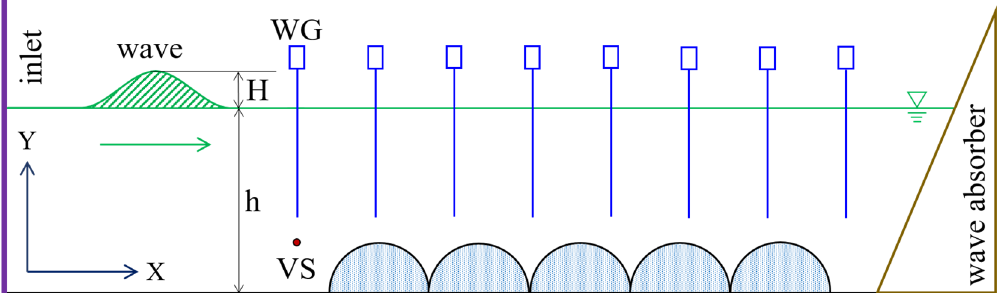
Figure 4. Computational layout for solitary wave passing over the breakwaters.